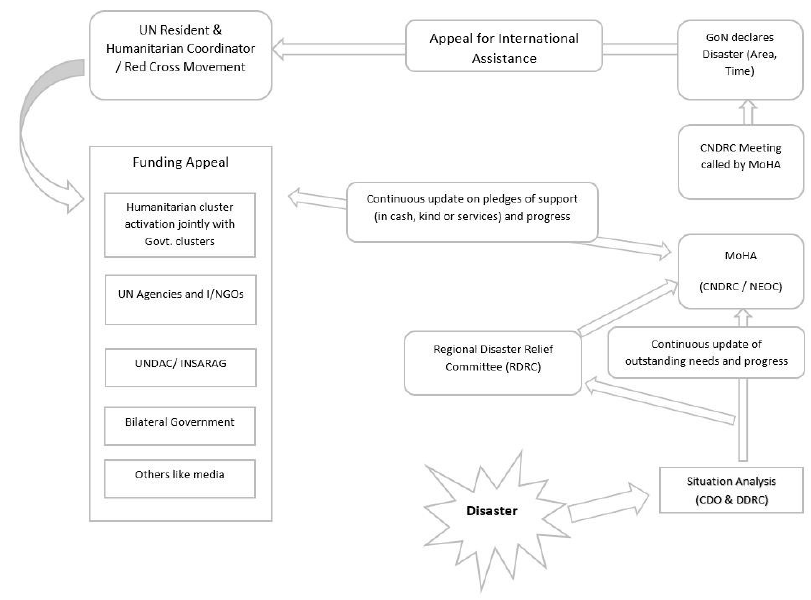
Figure 3. National and international assistance and coordination structure during an emergency. (Note: Acronyms. 6 Source: GoN MoHA (2013).